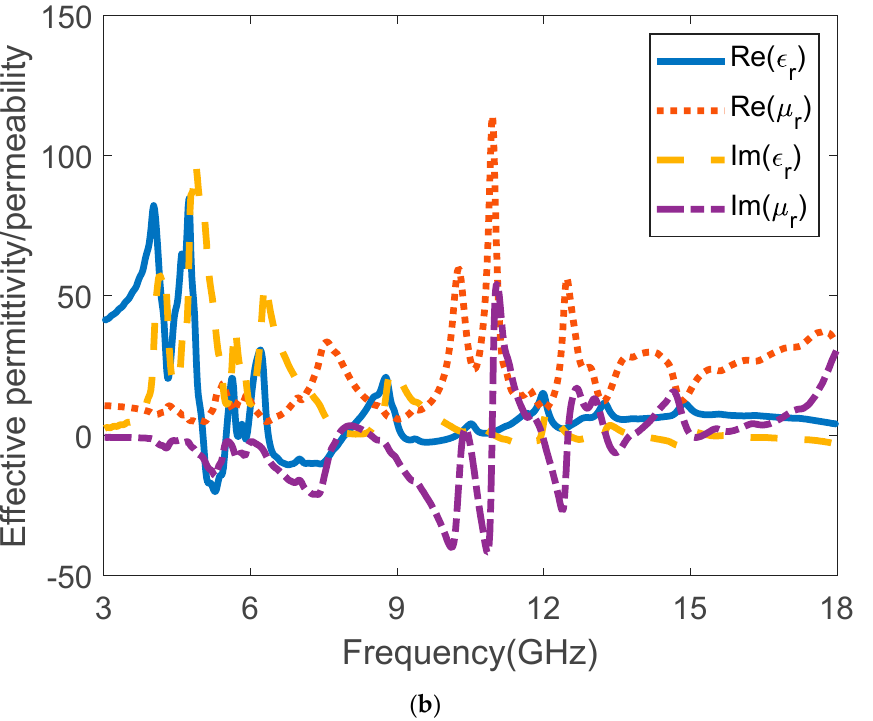
Figure 2. I-shaped 7x7 MTM array analysis: ( a ) S-parameters, ( b ) effective electromagnetic parame- ters (permittivity and permeability).